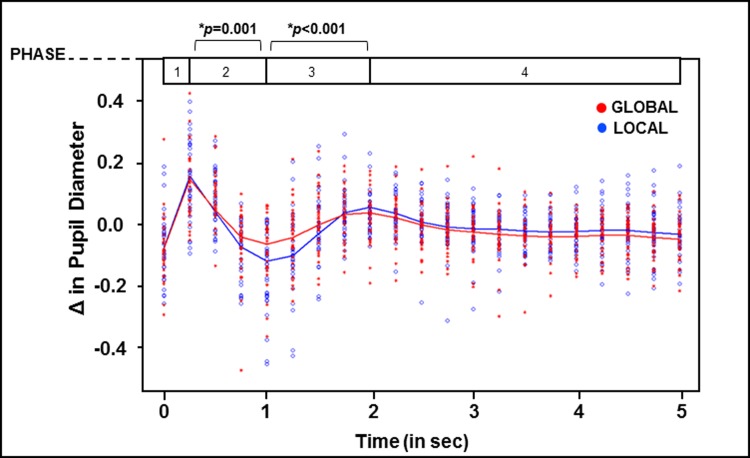
Task-induced pupil response.Pupil waveforms depicting task-induced pupil response during the global and local conditions. Phases are depicted at the top of the graph and significance is indicated.